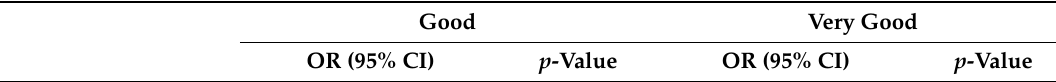
Table 4. Results of the multinomial logistic regression where participant’s general health (self- or parent-perceived) was dependent variable while MD adherence and level of physical activity were independent